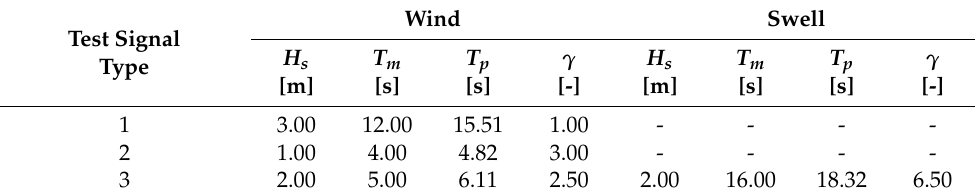
Table 1. Sea state parameters used for the wave elevation